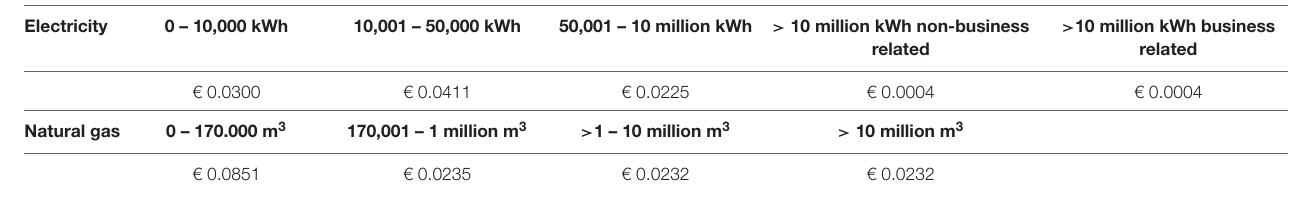
TABLE 1 | Overview of ODE